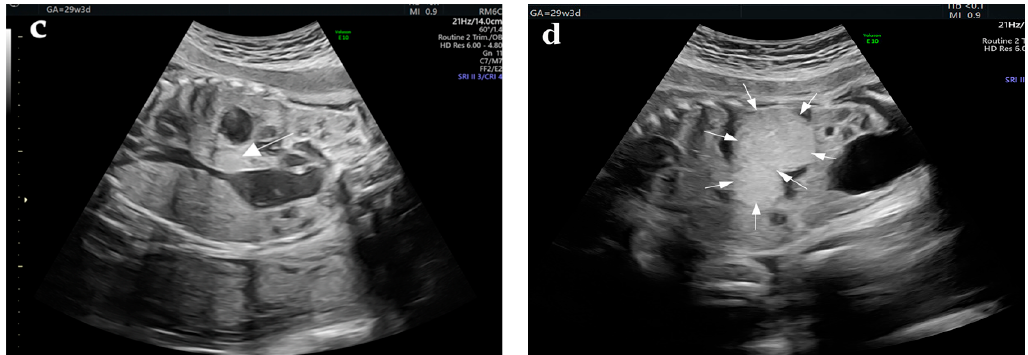
Figure 1. Evolution of ultrasonography findings of a pancreatic tumor in a 25-week-old fetus ( a ) and at 29 weeks ( b , c ). ( a ) Sagittal image shows an echogenic mass (arrows) with a well-differentiated contour in the fetal pancreas. ( b ) Transversal image revealed an increased echogenic mass at 29 weeks in the fetal pancreas (arrows) compared to the previous examination. ( c ) Coronal image shows compression of the inferior vena cava by the tumor, with retrograde dilation. ( d ) Longitudinal image revealed the pancreatic tumor.